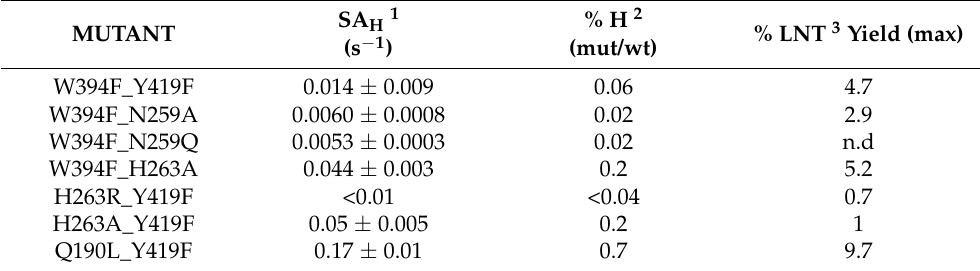
Table 2. Hydrolase activity on LNB- p NP and transglycosylation yields for LNT by LnbB double mu-